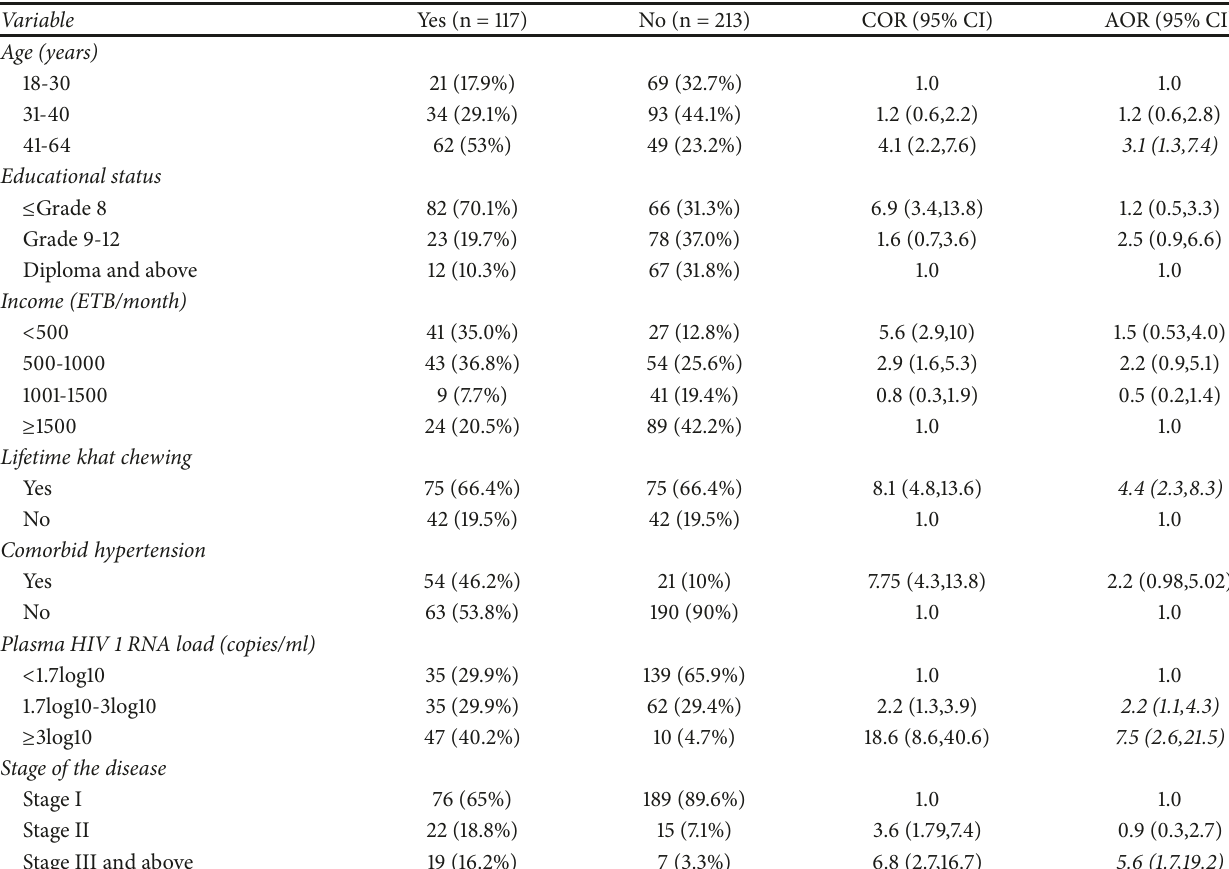
Table 4: Associated factors of cognitive impairment among HIV-positive patients at JUMC, Jimma, Ethiopia, 2018 (N =